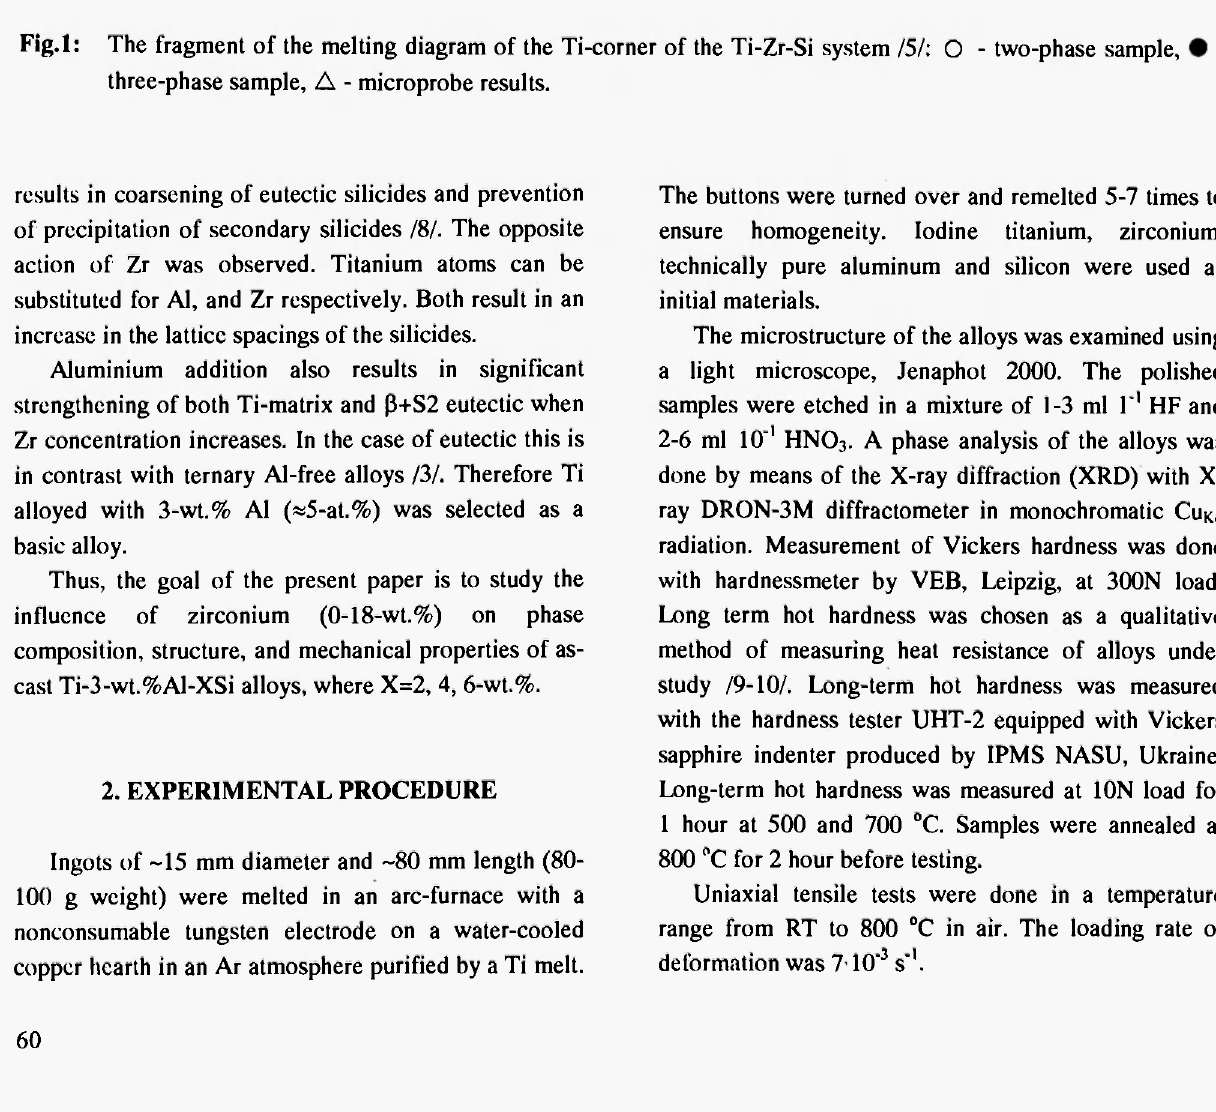
Fig.l: The fragment of the melting diagram of the Ti-corner of the Ti-Zr-Si system /5/: Ο - two-phase sample, three-phase sample, Δ - microprobe